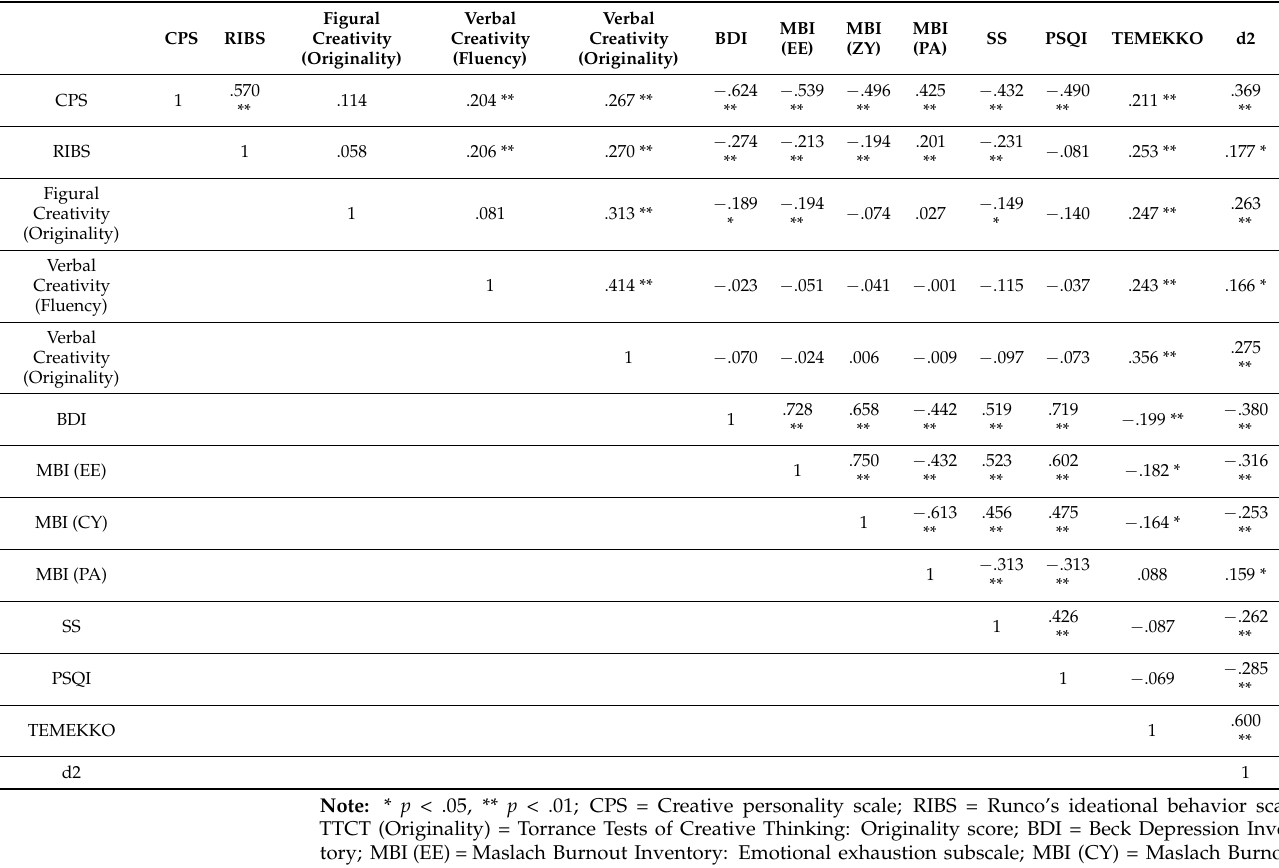
Table 4. Pearson’s correlations between creativity and clinical characteristics, as well as cognitive performance, in the total sample of participants (n =